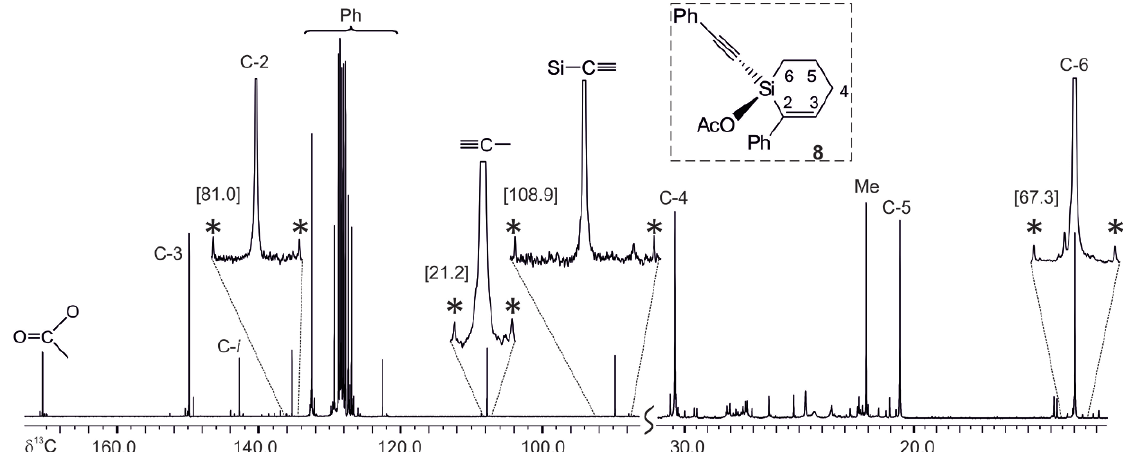
Figure 2. 13 C{ 1 H} NMR spectrum (100.5 MHz) of 1-acetoxy-1-(phenylethynyl)-2-phenyl-1-silacyclohex-2-ene, 8. In the expanded regions. the satellites are marked by asterisks, corresponding to 1/2 J( 29 Si, 13 C) spin-spin coupling constants. Respective values for coupling constants are listed in square